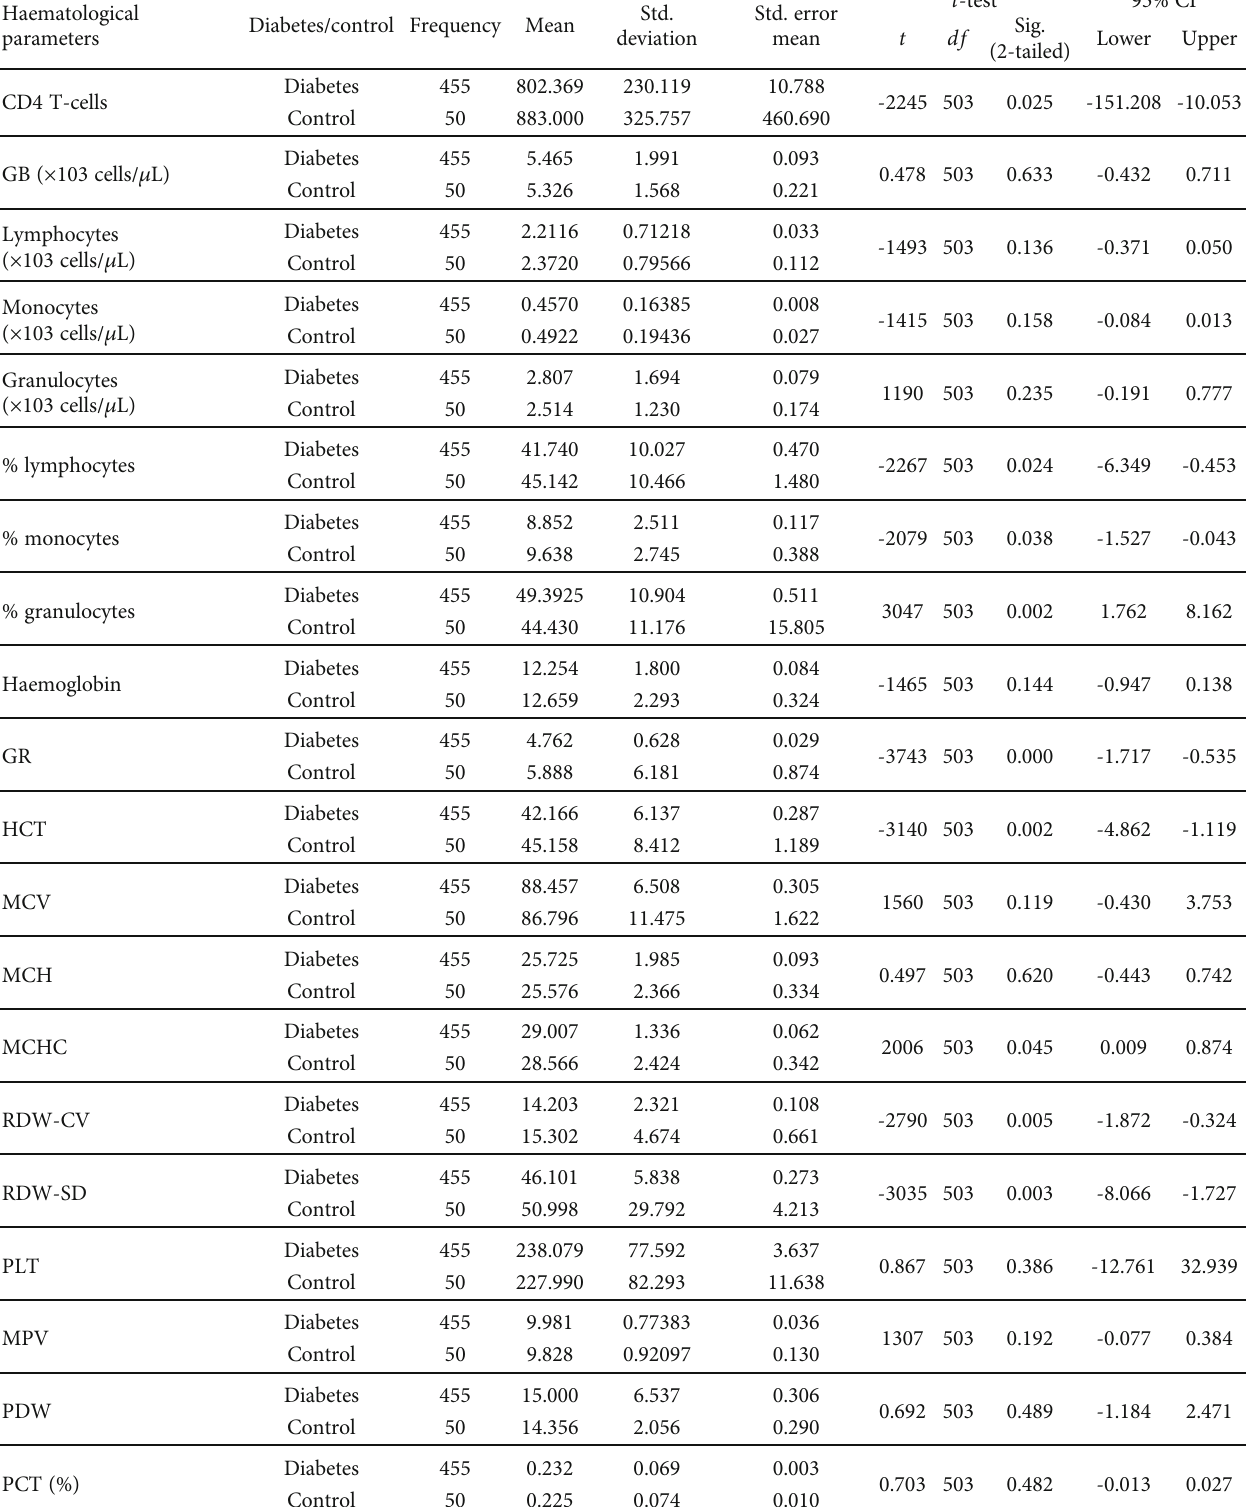
Table 4: Mean di ff erences in haematological parameters between the diabetic and control groups.